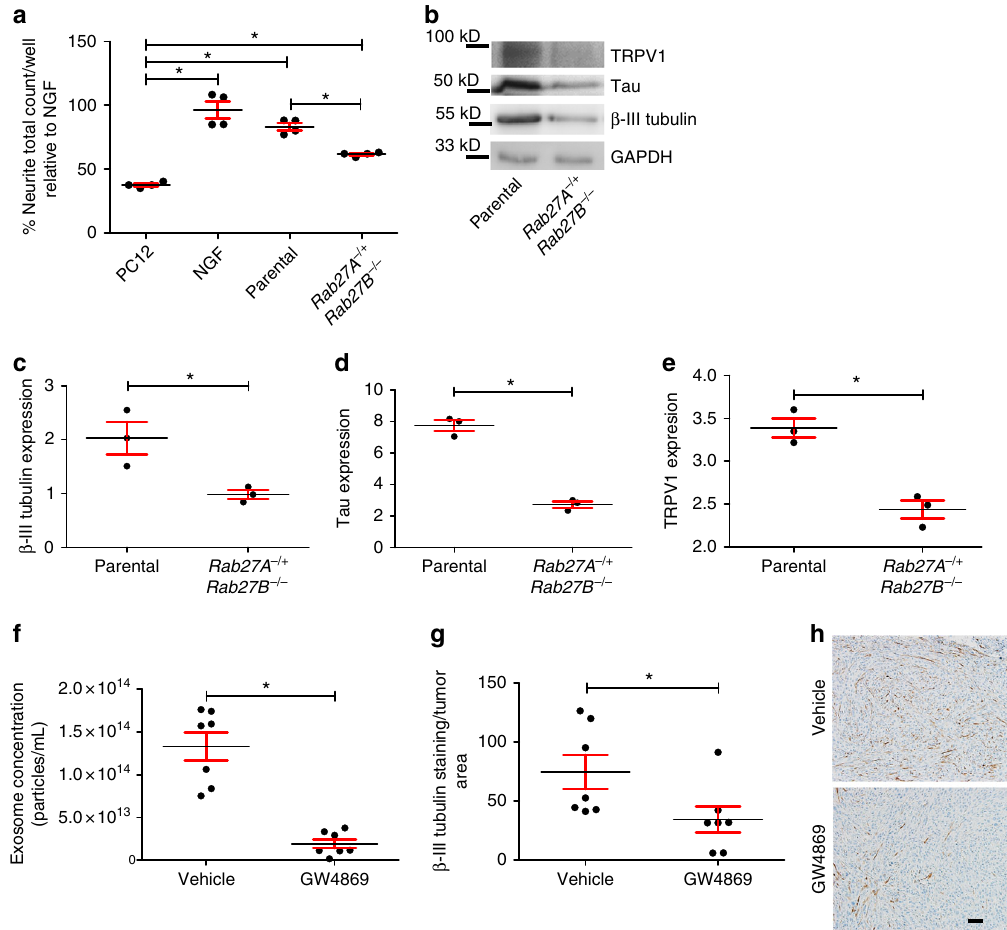
Fig. 5 Compromised exosome release leads to sparsely innervated tumors. a Neurite outgrowth of PC12 cells following exosome stimulation from the indicated sources. Stimulation with recombinant NGF (100 ng/ml) serves as a positive control. n = 4 technical replicates/condition; experiment repeated at least three times with biological replicates. Statistical analysis by one-way ANOVA with post hoc Fisher ’ s Least Signi fi cant Difference (LSD) test. LSD p values reported; * p ≤ 0.02. The variance between groups compared is similar. Central value used is the mean. All comparisons and p values found in Supplementary Table 4. b Western blot analysis of whole tumor lysate from mice bearing mEERL parental or Rab27A − / + Rab27B − / − tumors. n = 3 technical replicates. n = 4 biological replicates. Western blots have been cropped for clarity and conciseness. Western blot quanti fi cation by densitometry for c β -III tubulin, * p <0.05; d Tau, * p <0.0001; and e TRPV1, * p <0.001. Statistical analysis by unpaired, two-tailed Student ’ s t -test. Central value used was the mean. The variance between groups compared is similar. f Nanoparticle tracking analysis of exosomes puri fi ed from the plasma of tumor bearing mice treated with GW4869 or vehicle. Statistical analysis by two-tailed Student ’ s t -test. Central value used was the mean. The variance between groups compared is similar; * p <0.0001. g Quanti fi cation of β -III tubulin IHC staining of tumors from mice ( n = 7/group) treated with GW4869 or vehicle; Statistical analysis by unpaired, two-tailed Student ’ s t -test; * p <0.05. Central value used was the mean. Experiment performed once. The variance between groups compared is similar. h En face bright fi eld representative images of IHC for β -III tubulin of mEERL tumors treated with GW4869 or vehicle. n = 7/group. Scale bar, 100 µ m. All error bars are standard